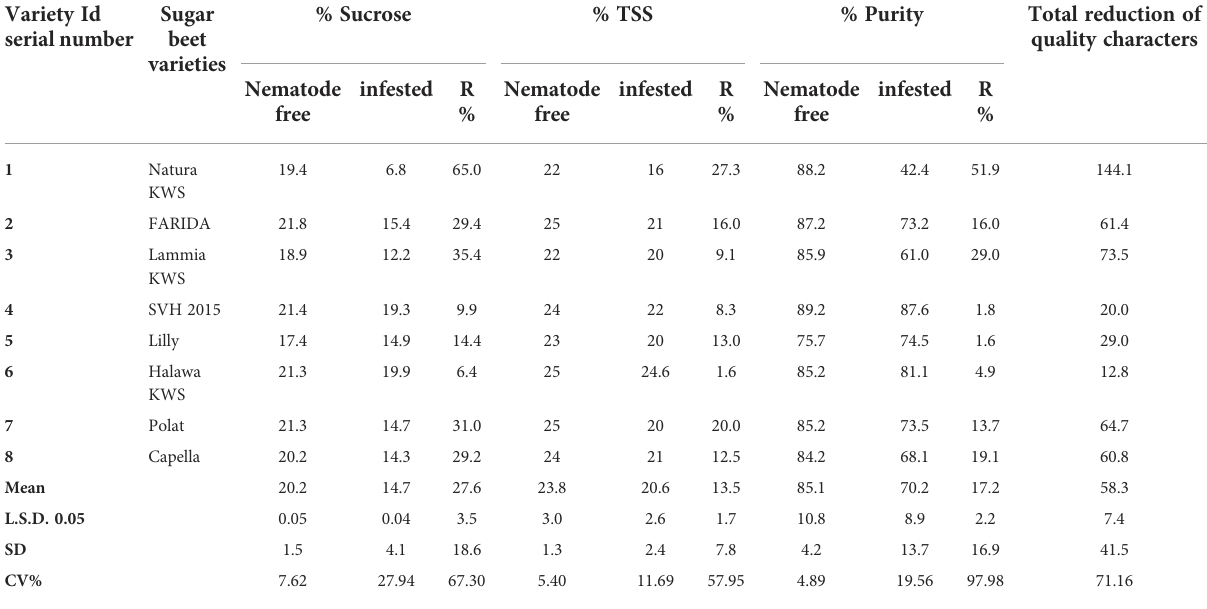
TABLE 6 Sucrose, total soluble solids (TSS), and purity percentages of the screened sugar beet varieties (Beta vulgaris saccharifera) as in fl uenced by the infection of root-knot nematode, Meloidogyne incognita . Variety